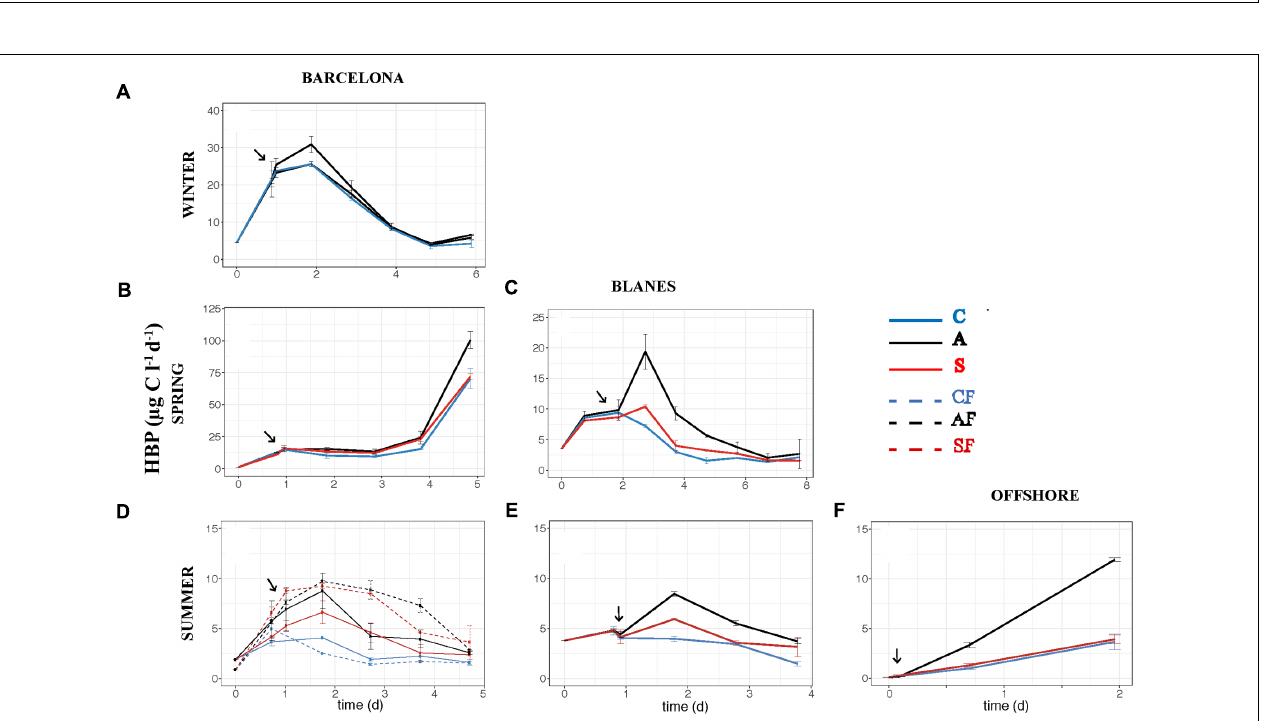
FIGURE 4 | Heterotrophic bacterial production – HBP ( µ g C l − 1 d − 1 ) – over the incubation time in the six experiments: (A) WI-BCN, (B) SP-BCN, (C) SP-BLA, (D) SU-BCN, (E) SU-BLA, (F) SU-OFF. The same abbreviations and comments than in Figure 3 are applicable.